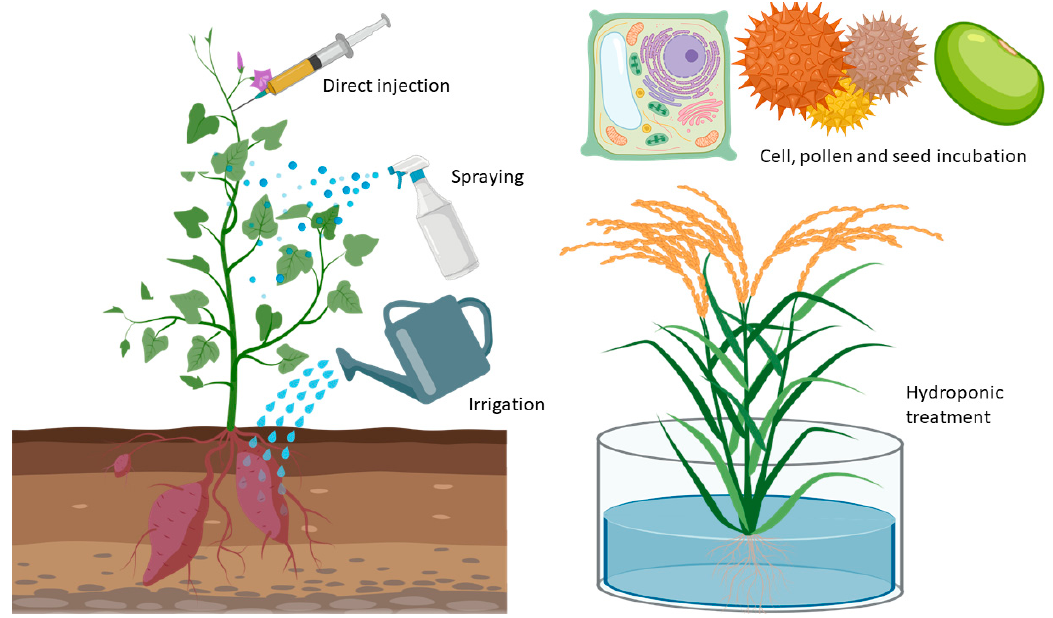
Figure 2. Different types of nanoparticles (NP)/plant exposure methodologies. Figure 2. Di ff erent types of nanoparticles (NP) / plant exposure